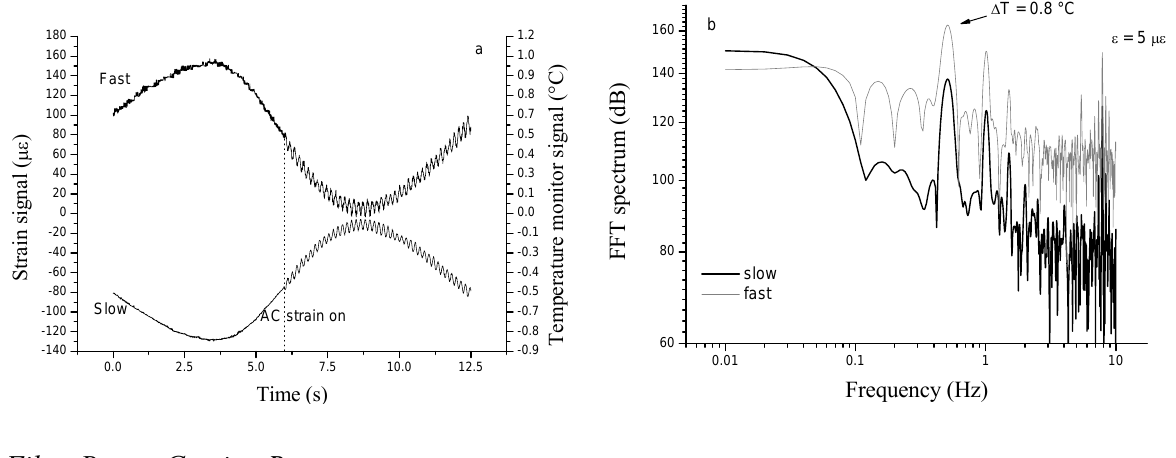
Figure 6. (a) Time response of the laser-locked system when a sine voltage is applied to the PZT (8 Hz) attached to the FBG and a periodic temperature change created with the PID controller (0.5 Hz). (b) FFT spectrum of Figure 6a (50 mHz resolution bandwidth). The traces were shifted by 30 dB for sake of clarity.